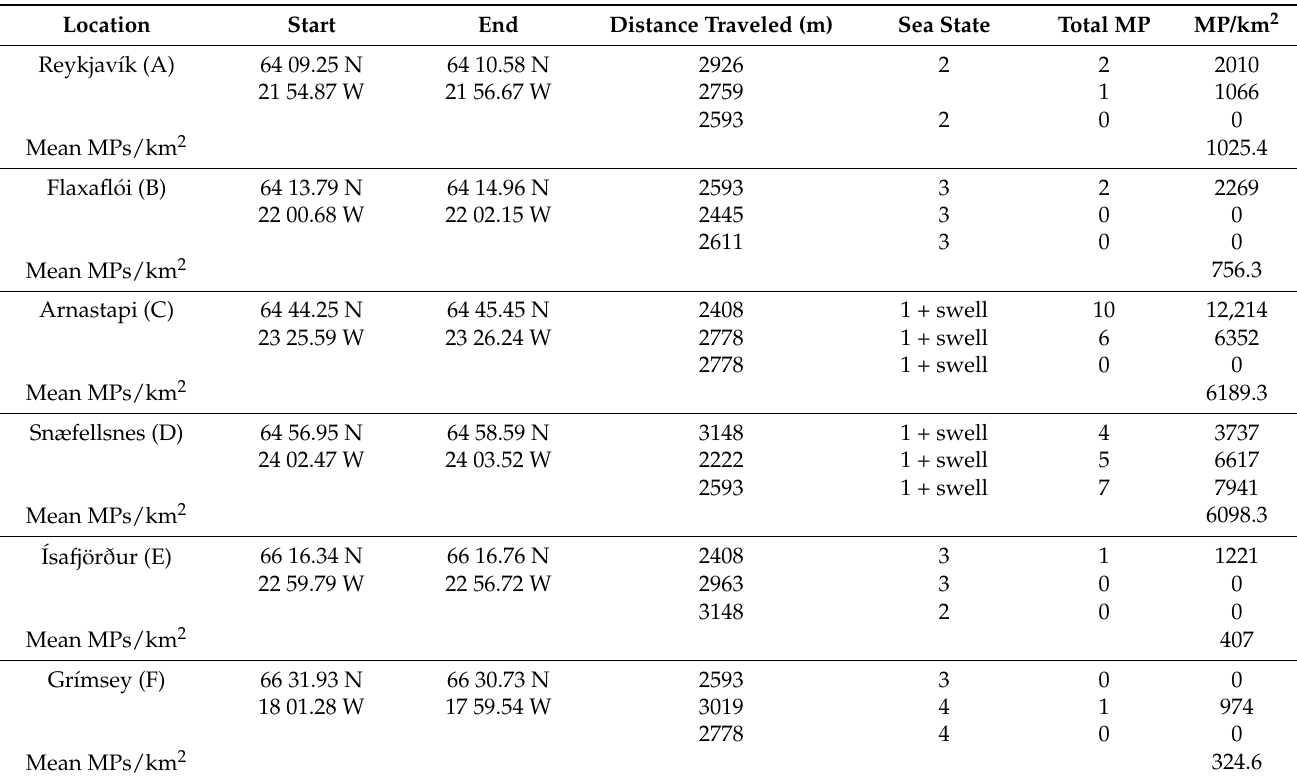
Table 1. Overview of results. For each station the total MPs, distance trawled, theoretical abundance per km 2 , mean MPs per location, and sea state are